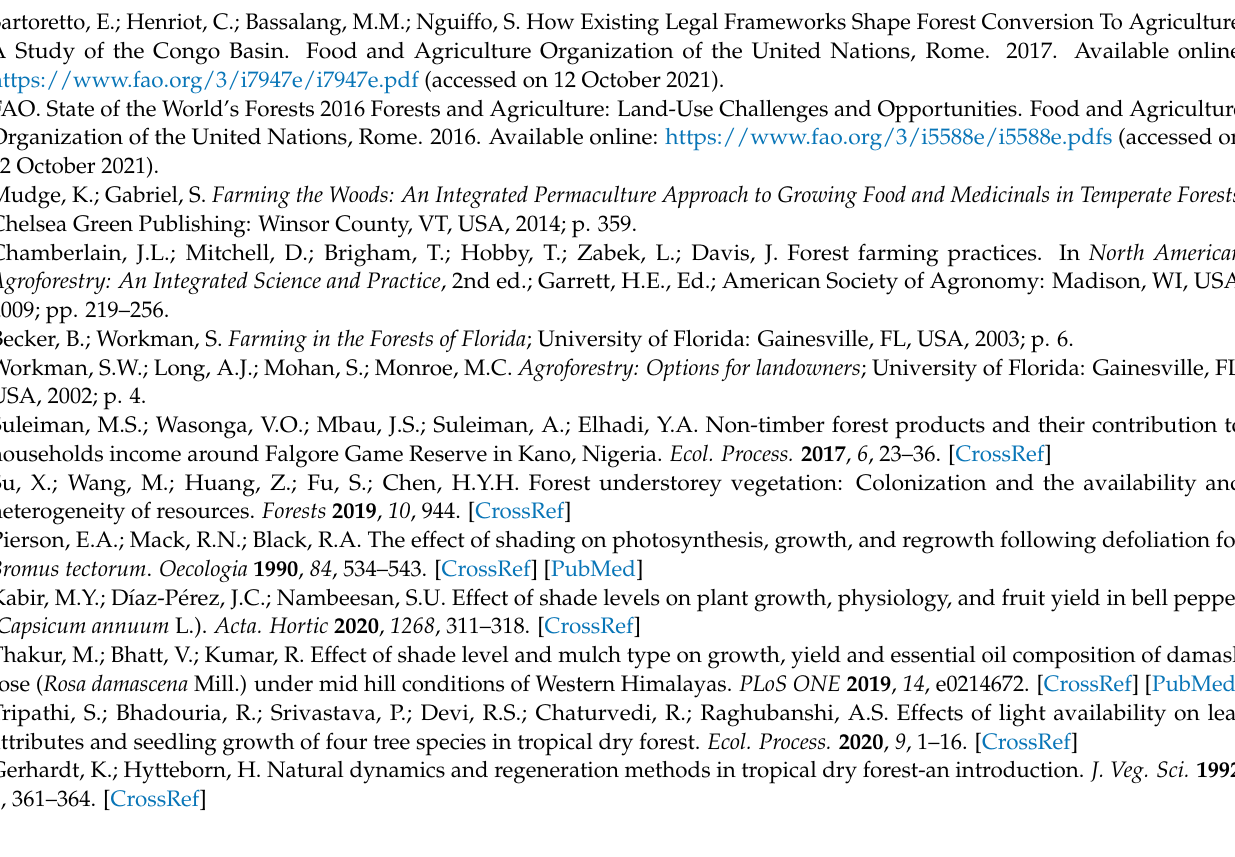
Data Availability Statement: Data is contained within the article and a Supplementary Table S1 and Table